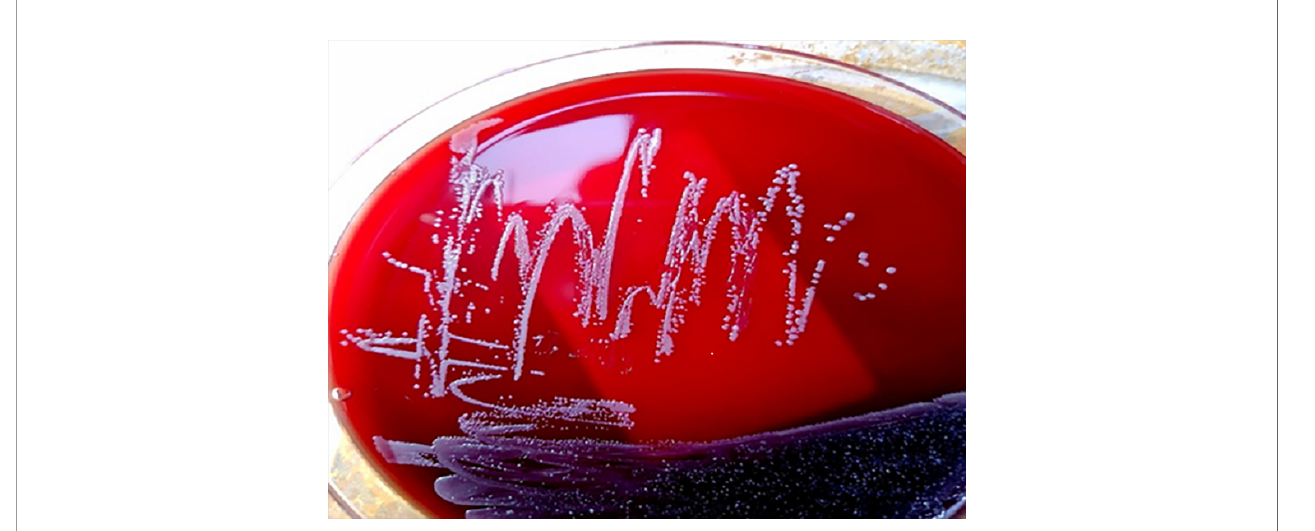
FIGURE 1 | The phenotype of H. huttiense after 24 h aerobic ( Figure 2 ). The MALDI-TOF MS results indicated 99.2% homology with H. huttiense ( Figure 3 ). The 16S rRNA gene sequence was consistent with that of H. huttiense . Phylogenetic branch as H. huttiense ( Figure 4 ). The isolates were thus